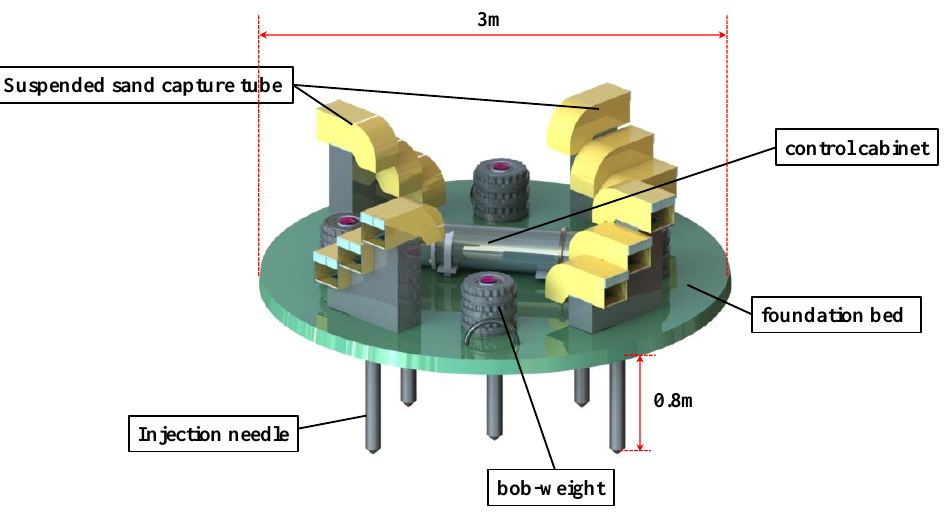
Figure 1. Schematic of the 3D trap.